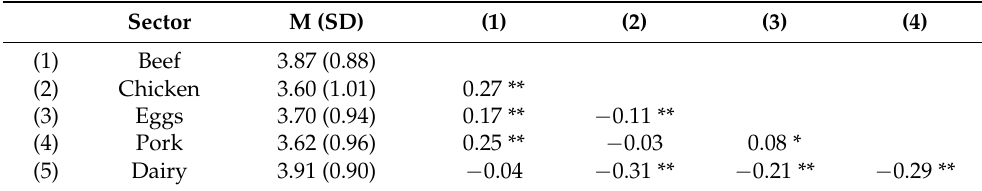
Table 5. Summary of mean difference in consumer perception of change in farm animal welfare over the last 10 years across five production sectors.